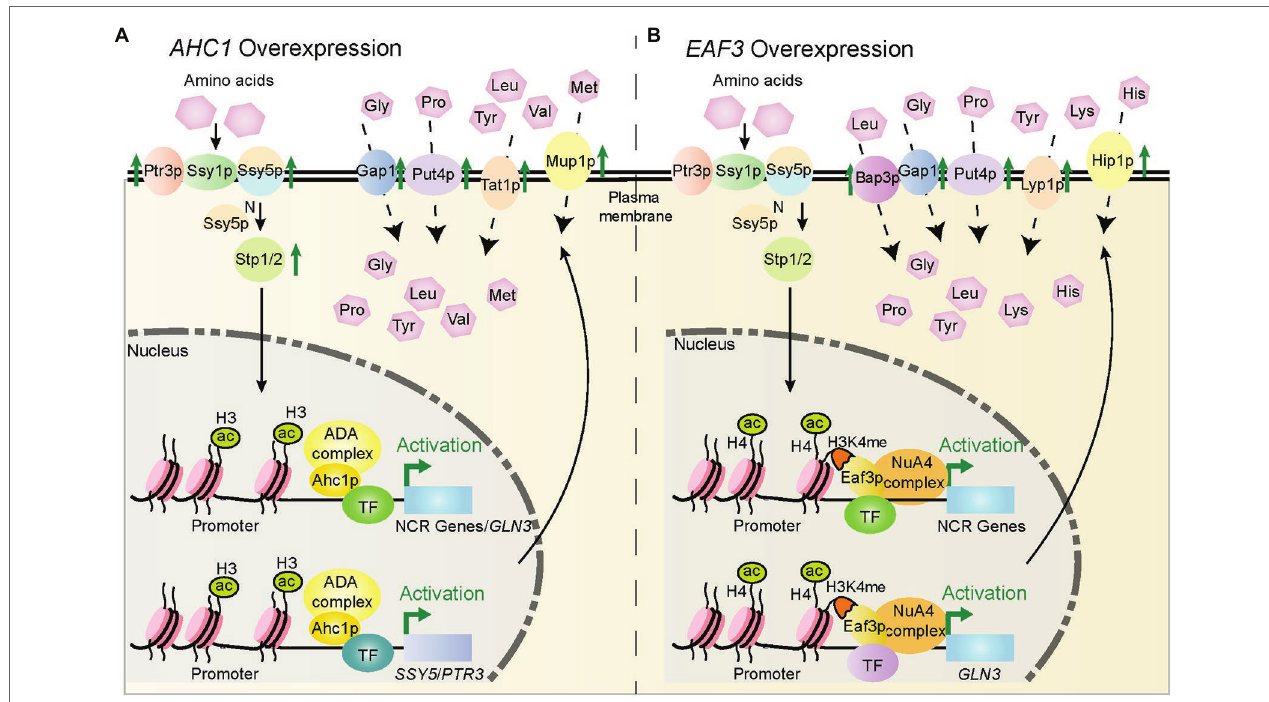
FIGURE 6 | Schematic diagram of the potential mechanism by which AHC1 / EAF3 overexpression regulates key nitrogen metabolism genes. (A) Potential mechanism by which AHC1 overexpression regulates nitrogen metabolism. Ahc1p may activate gene expression together with other transcription factors, and its effects are enhanced by overexpression of AHC1 . Ahc1p depends on the ADA complex for its function to acetylate histone H3K14 sites on the promoters of target genes. This loosens nucleosomes and promotes the binding of Gln3p or other transcription factors, thereby activating the expression of target genes, resulting in upregulation of target gene expression, and eventually increased utilization of non-preferred nitrogen sources. (B) Potential mechanism by which EAF3 overexpression regulates nitrogen metabolism. Eaf3p may act in a similar manner to Ahc1p. However, Eaf3p recognizes H3K4me sites on target gene promoters through its N-terminal chromodomain and localizes the NuA4 histone acetyltransferase complex to target gene